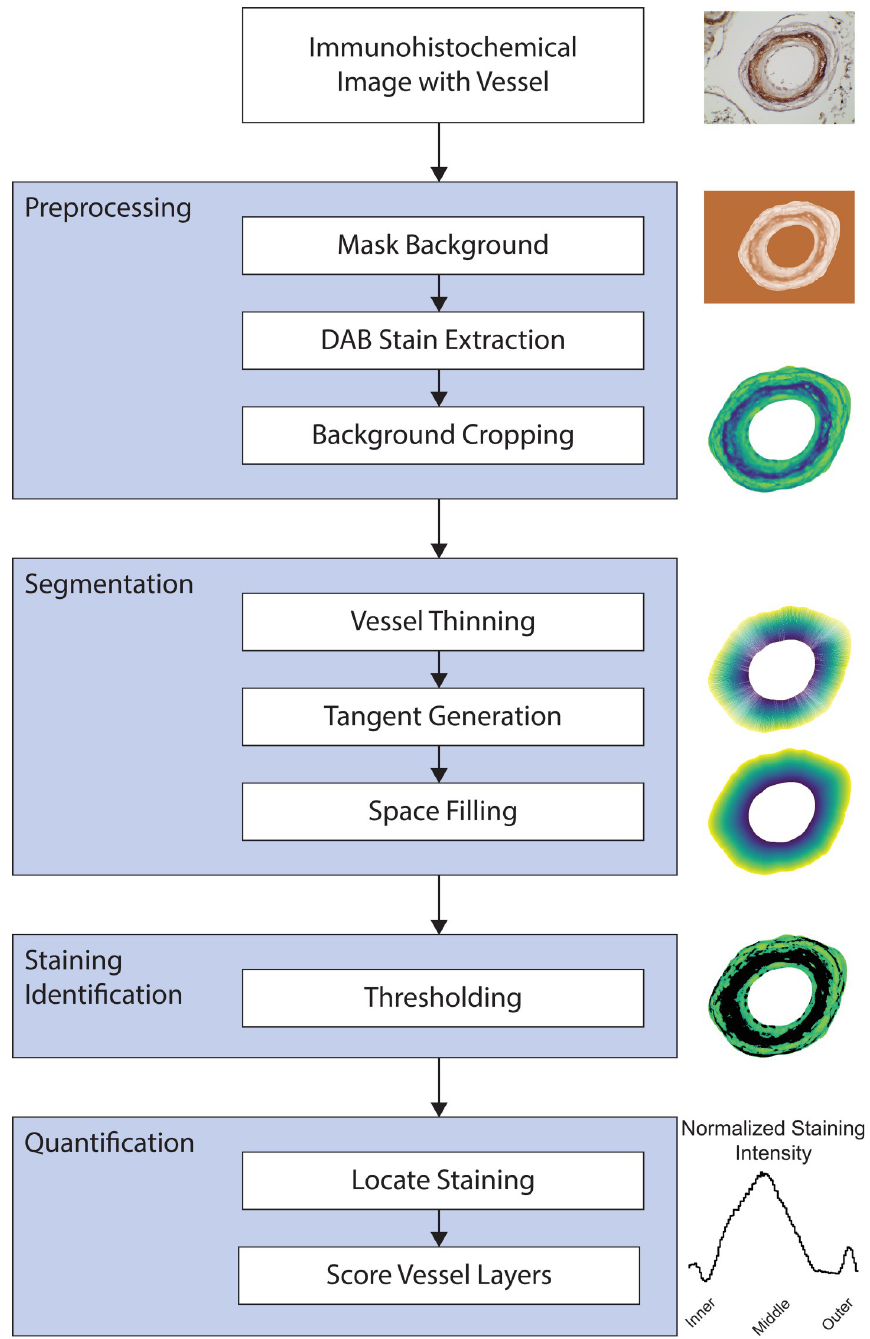
Fig 7. Image analysis workflow depicting VesSeg. A leptomeningeal vessel stained for NOTCH3 was used to demonstrate the process (top panel). The artery was pre-processed using sequential color deconvolution to remove the hematoxylin signal and to focus on the DAB signal (second panel). Masking and then cropping were performed on the processed image to limit analysis to the vessel wall. Spokes were generated for the vessel, resulting in radial segmentation of the wall (third panel). Furthermore, stained regions were thresholded using a custom criterion for processing (fourth vessel). Finally, a histogram depicting the frequency of staining along the vessel wall width was generated (higher frequency corresponds to increased level of staining in that region; last